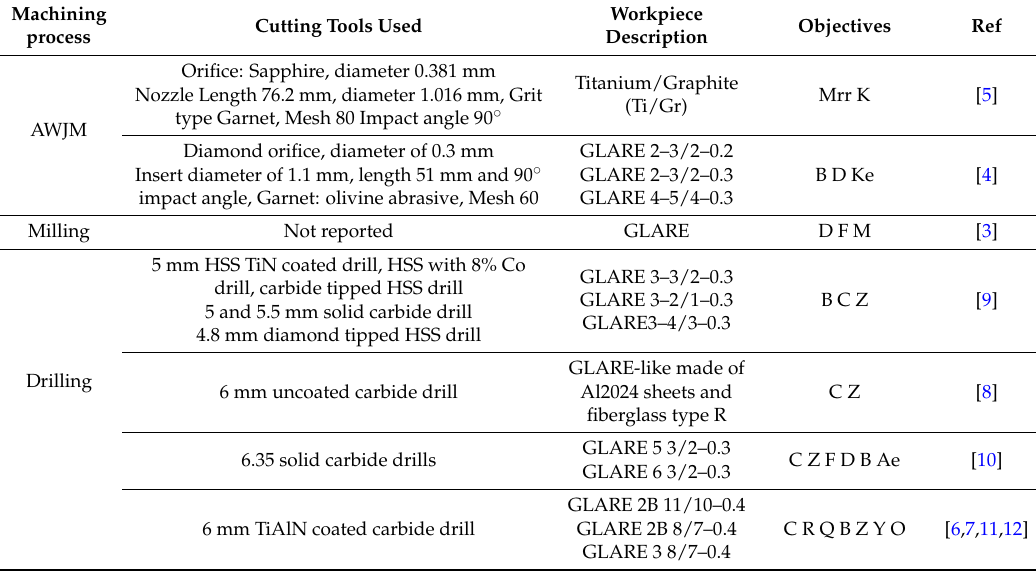
Table 1. Summary of the reported studies on machining fiber metal laminates